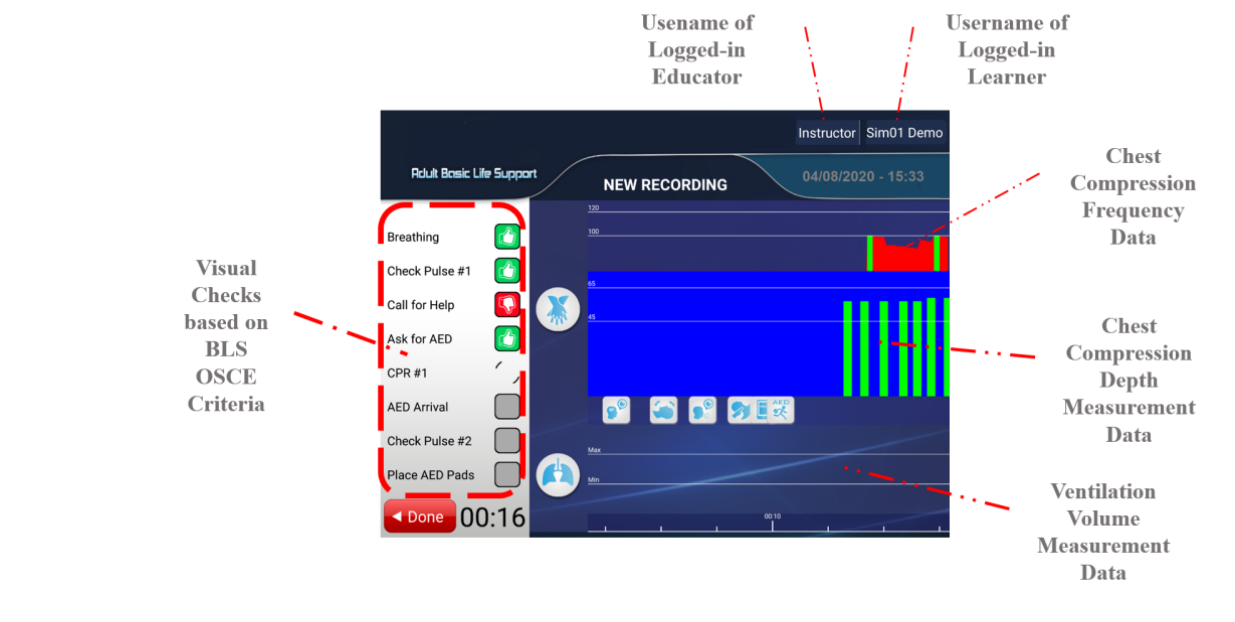
Figure 5. Screen capture of the Hands-on app.